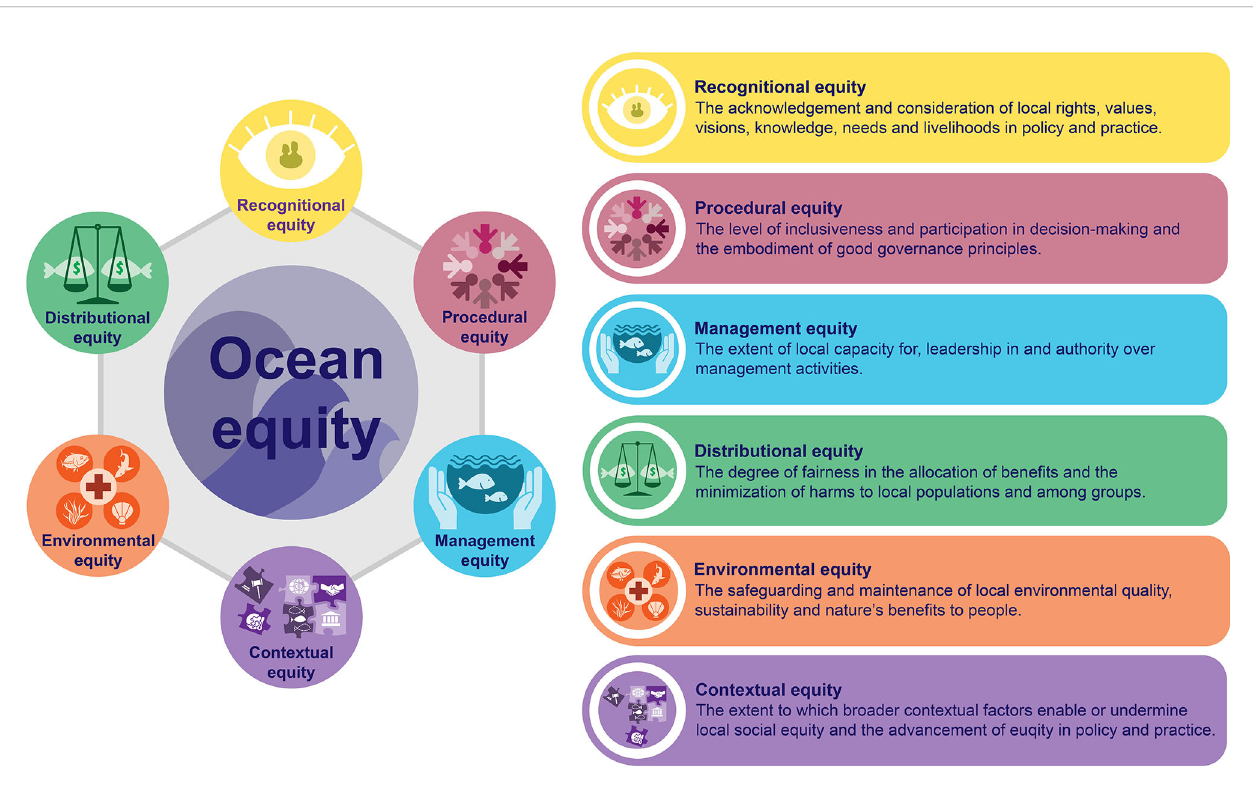
FIGURE 1 | What is ocean